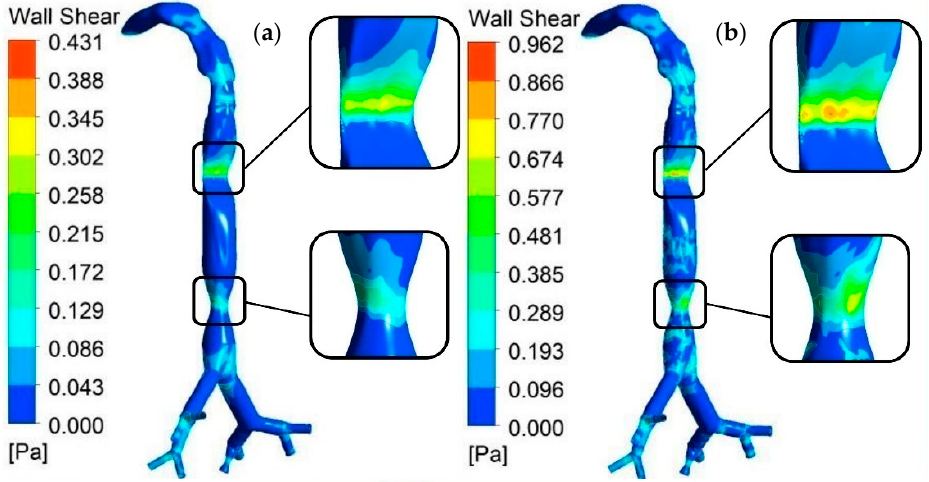
( c ) Figure 9. Cont